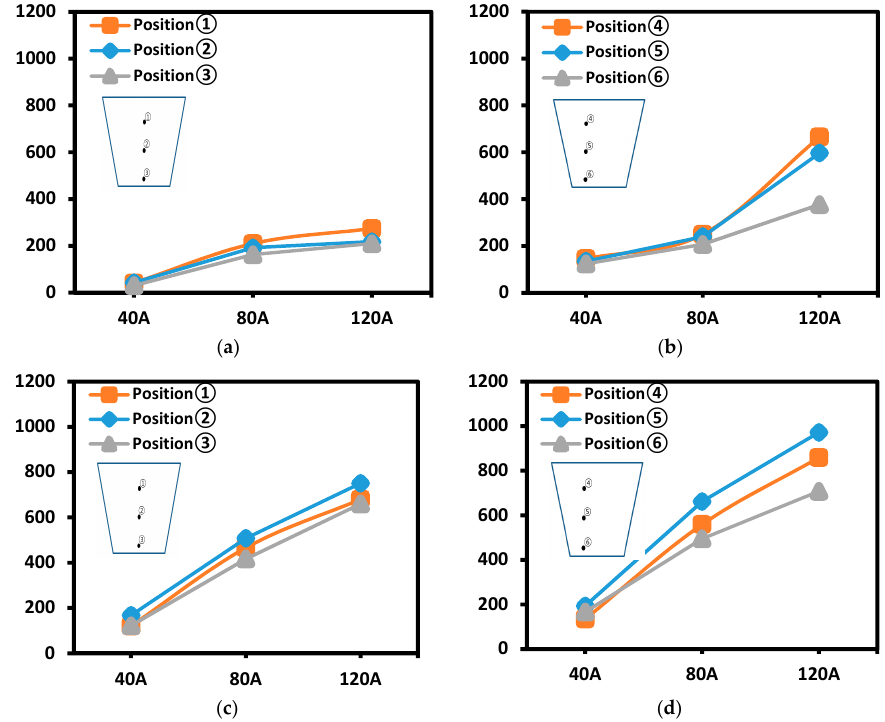
Figure 6. Magnetic induction density of according to magnetic impression method: ( a ) Measurement point; of center to CAMP; ( b ) measurement point of surface to CAMP; ( c ) measurement point of center to CSMP; ( d ) measurement point of surface to CSMP.